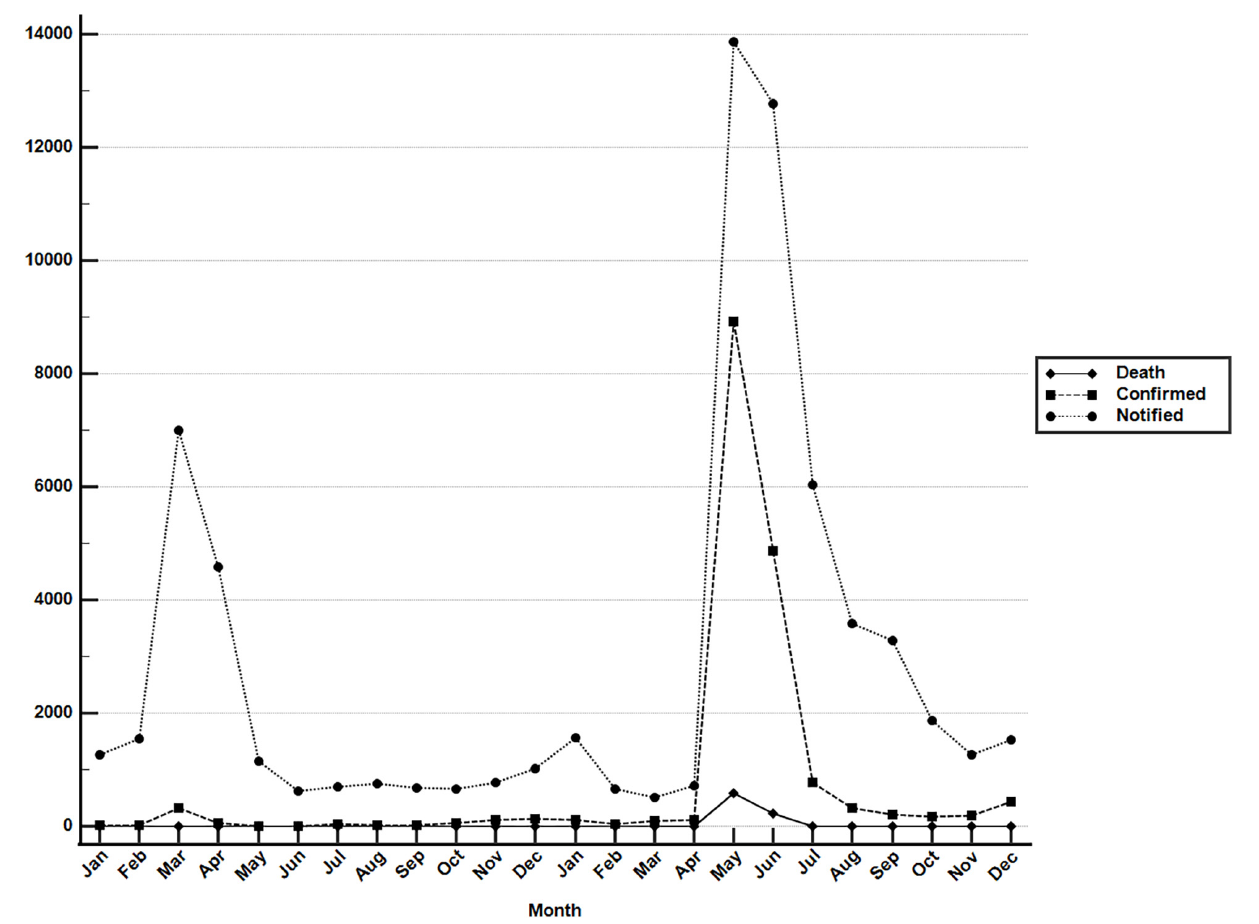
FIGURE 1 | Monthly COVID-19 data between January 2020 and December 2021 in Taiwan. Monthly data of confirmed COVID-19 cases and deaths resulting from COVID-19 between 1 January 2020 and 31 December 2021. These data were retrieved from the notifiable diseases surveillance system maintained by the Taiwan CDC. Source of data: https://nidss.cdc.gov.tw/nndss/disease?id=19CoV.